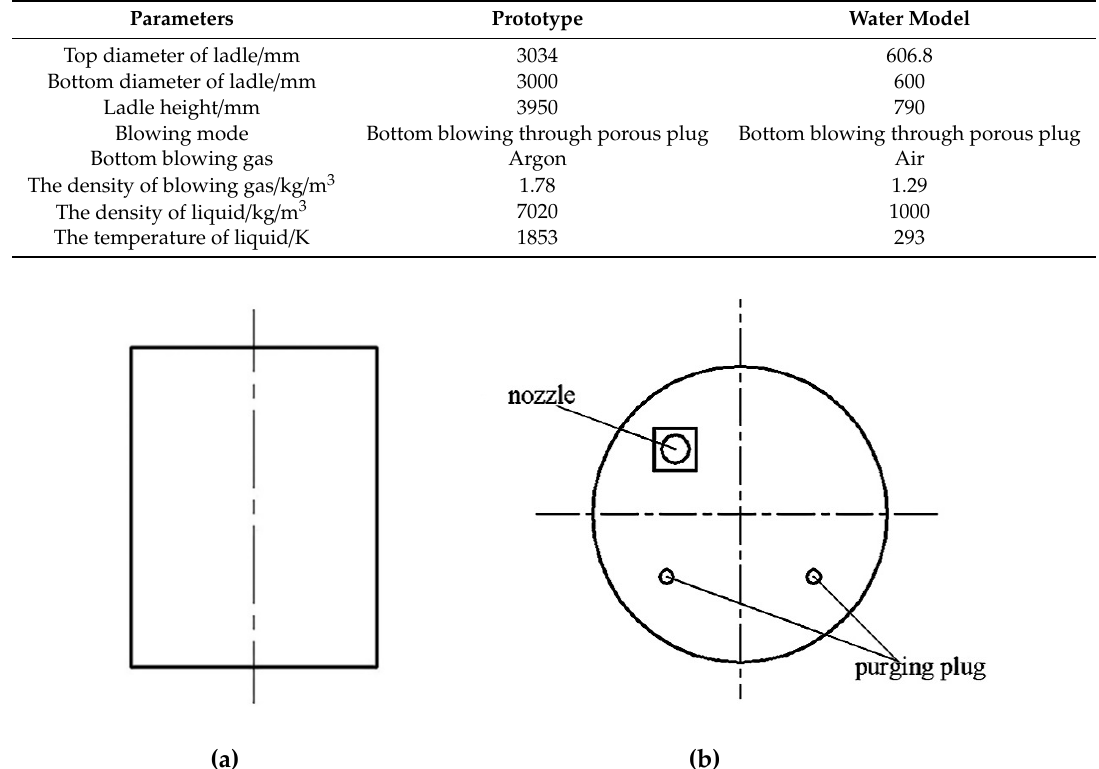
Table 1. The dimension data of the water model and prototype.